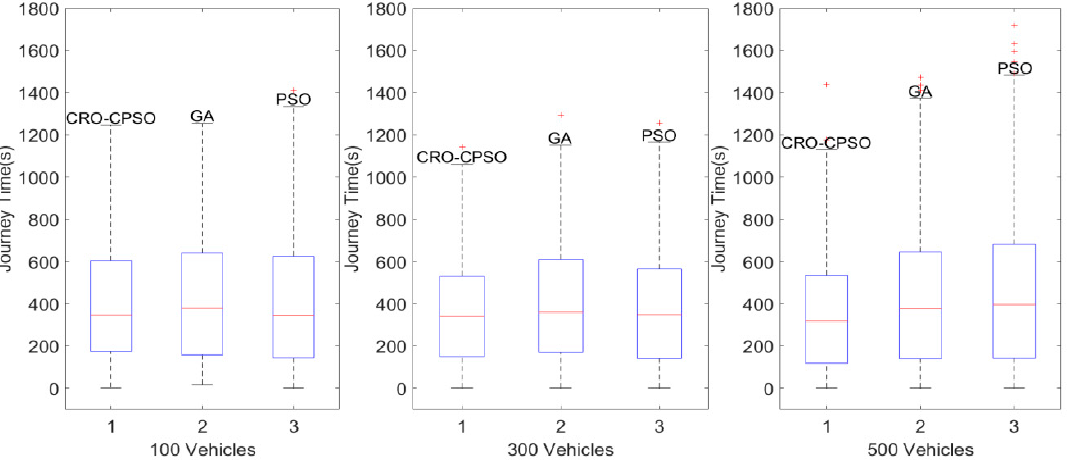
Figure 9. Boxplot representation of distribution results for the journey times of vehicles in Changsha County scenarios with 100, 300 and 500 vehicles.